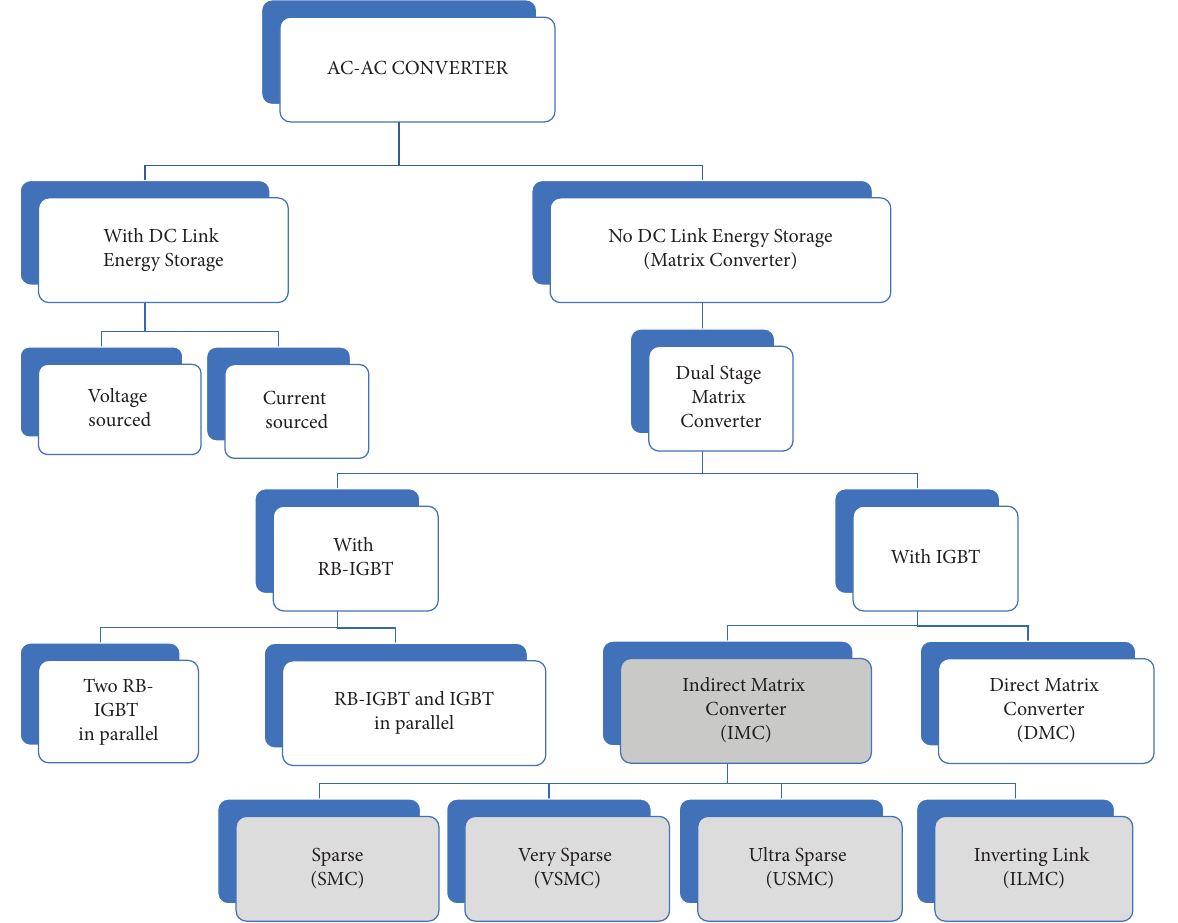
Figure 2: Te classifcation of three-phase AC-AC converters (RB: reverse blocking) Table 1: Te design parameters of the PMSG used in this work.